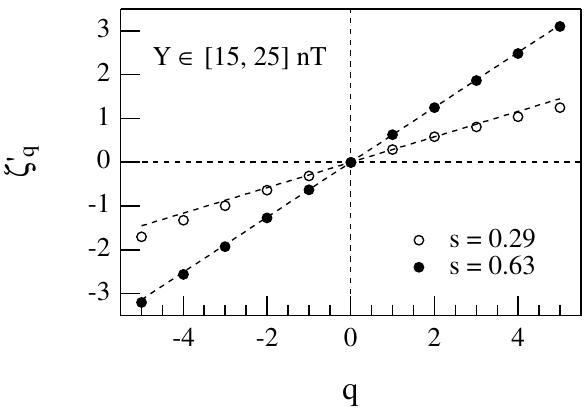
Fig. 5. Plot of ζ 0 (q) vs. q to confirm the mono-fractal scaling with Fig. 6. Plot of ζ 0 (q) vs. q for the two solutions found in the interval Fig. 5. Plot of ζ 0 ( q ) vs q to confirm the mono-fractal scaling with scaling exponent s = 0 . 54 in the range scaling exponent s = 0 . 54 in the range Y ∈ [ 45 , 55 ] nT. The dashed Fig. 6. Plot of ζ 0 ( q ) vs q for the two solutions found in the interval Y ∈ [15 , 25] nT . While one solution (solid Y ∈ [ 15 , 25 ] nT. While one solution (solid circle) shows the linear line is the line ζ 0 (q) = 0 . 54 q . dependence on q , as expected for a mono-fractal scaling, the second Y ∈ [45 , 55] nT. The dashed line is the line ζ 0 ( q ) = 0 . 54 q . circle) shows the linear dependence on q , as expected for a mono-fractal scaling, the second one (empty circle) one (empty circle) displays a clear anomalous dependence on q . displays a clear anomalous dependence on q .